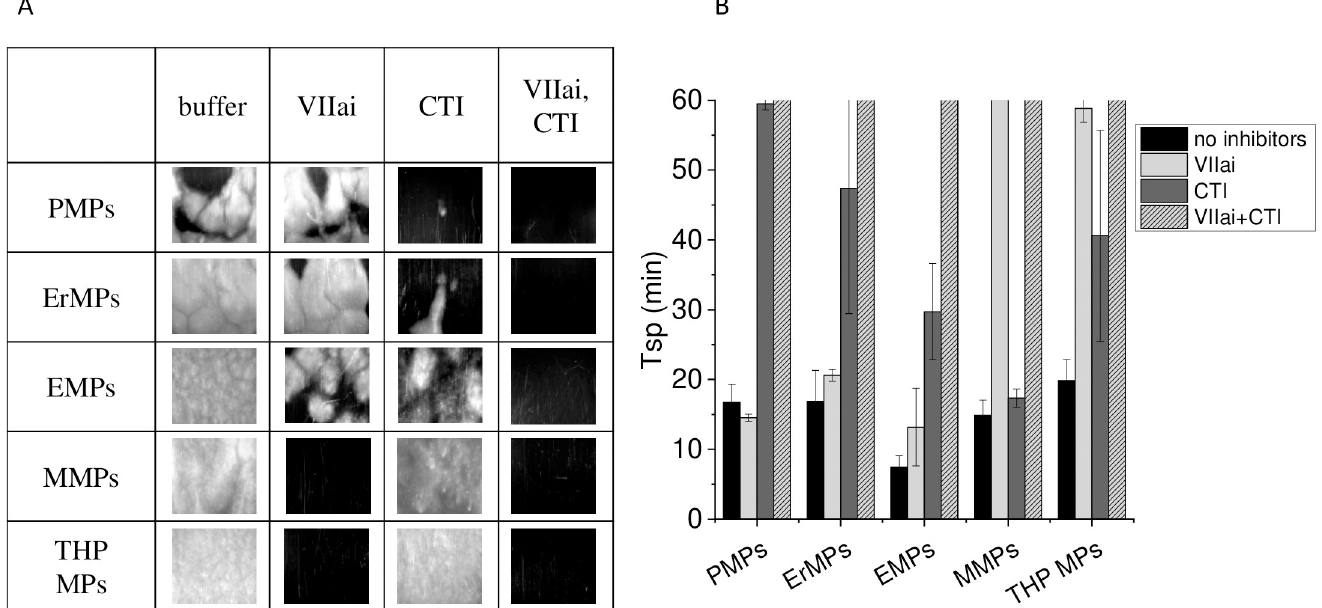
Fig 4. Activation pathway from MPs. Photos at 60 min of plasma supplemented with MPs of different origins in the Thrombodynamics test without any inhibitors, with 100 nM VIIai (TF pathway inhibitor), with 200 μ g/ml CTI (contact pathway inhibitor) or both inhibitors. MPs were supplemented at arbitrary concentrations, which induced the appearance of clotting centres within 10–20 min in samples without inhibitors. That was optimal for checking inhibitor effects. B. Mean ± sd of Tsp in plasma supplemented with MPs without inhibitors and with one or both inhibitors. Three repeats were carried out for PMPs and THP MPs and two repeats for ErMPs, EMPs and MMPs. PMPs–platelet microparticles, ErMPs–erythrocyte microparticles, EMPs–endothelial microparticles, MMPs–monocyte microparticles, THP MPs–microparticles from monocyte